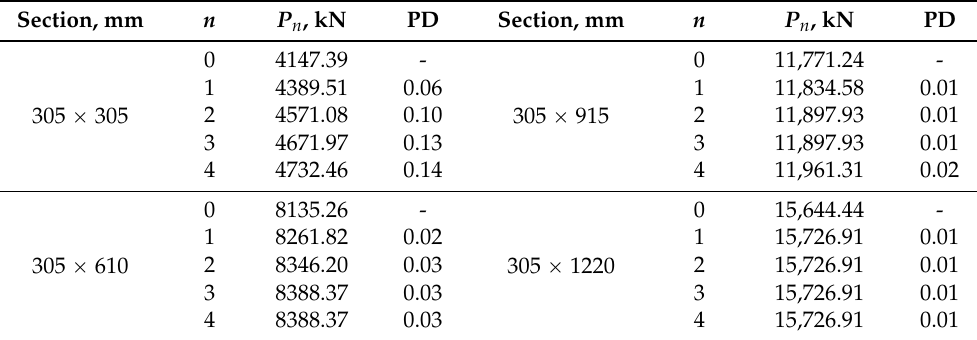
Table 14. Parametric study results. PD, percentage difference.